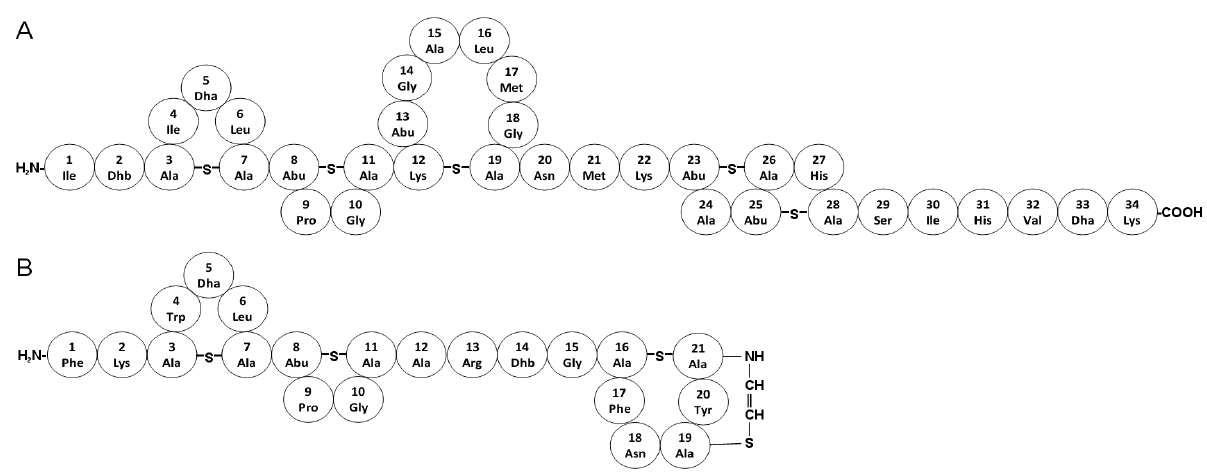
Figure 4. Covalent structures of two highly related bacteriosins. ( A ) Nisin A from Lactoccocus lactis and ( B ) Mutacin 1140 from Streptococcus mutans